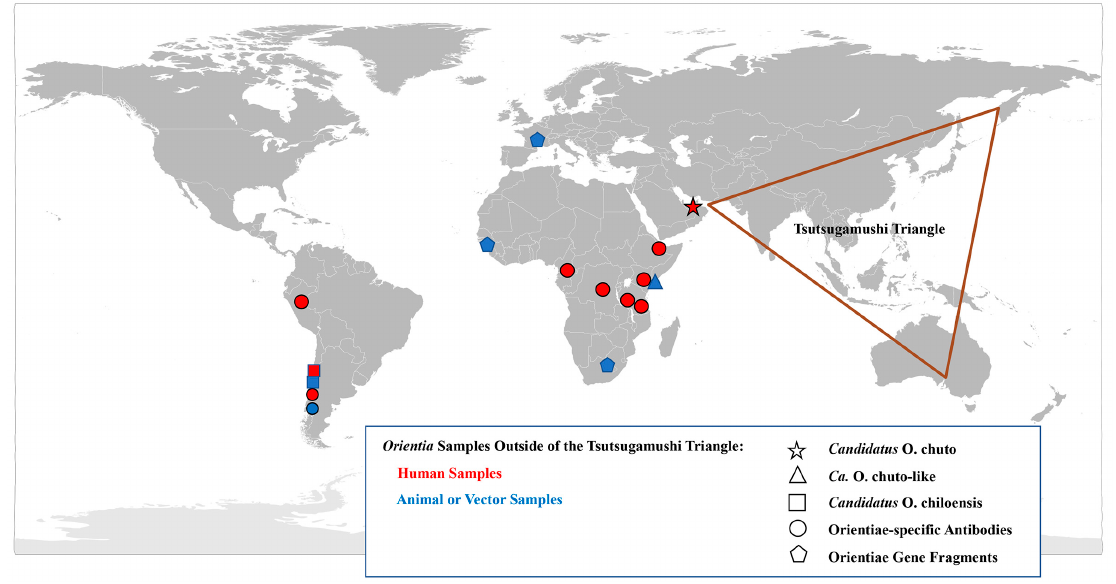
Figure 2. Geographical Distribution of Orientia spp. and the Scrub Typhus: A Worldwide Disease.